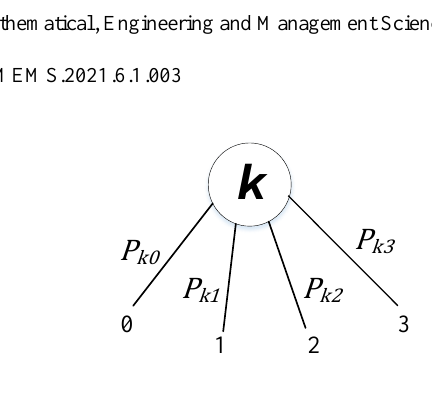
Figure 4. An MDD non-sink node modeling disk k .